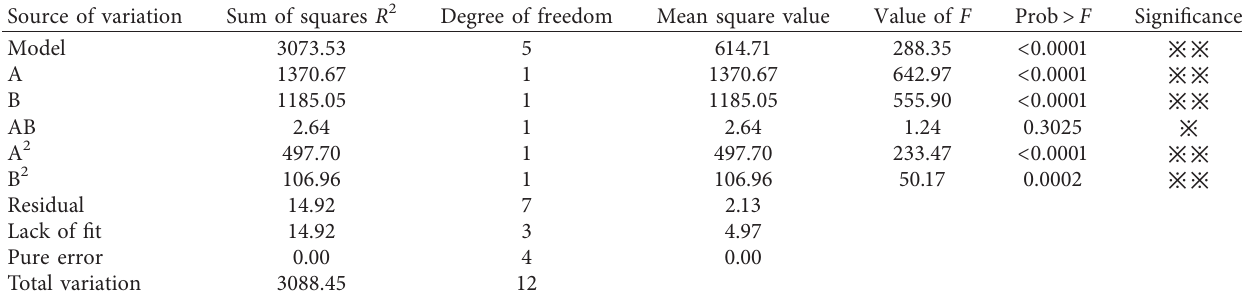
Table 6: Coefficient of regression equation and significance test for speed drop.